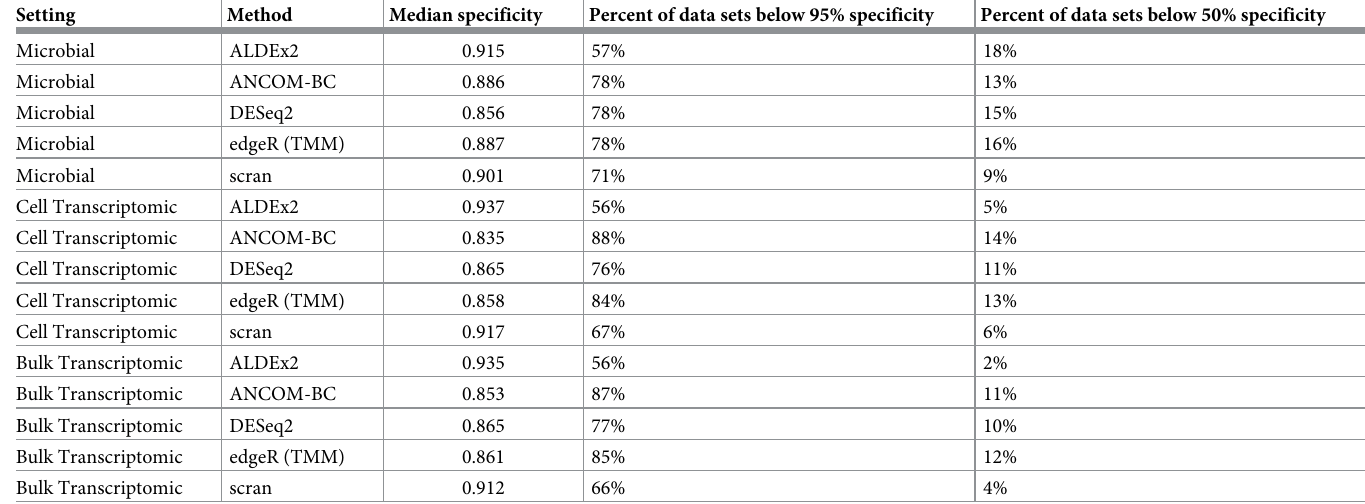
Table 1. Median and thresholded specificity by simulated setting, FDR � 0.05. Low specificity is a common outcome in simulated data. A majority of simulated data sets have false positive rates in excess of 5%. A minority of data sets have false positive rates in excess of 50%. Setting